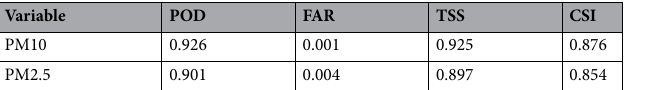
Table 4. Evaluation of forecasts for high concentration PM10/PM2.5 using